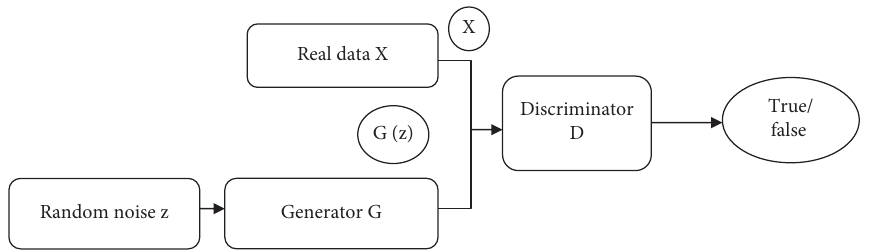
Figure 8: P-filling calculation process and structure.